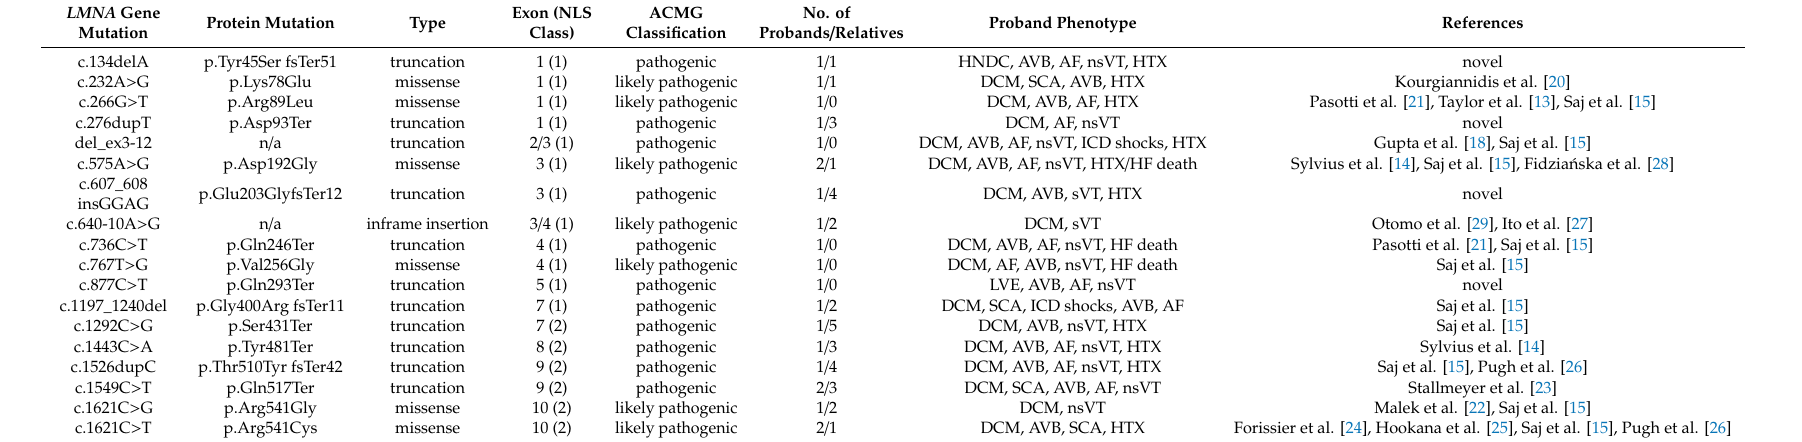
Table 1. Genotyping results and clinical phenotypes in